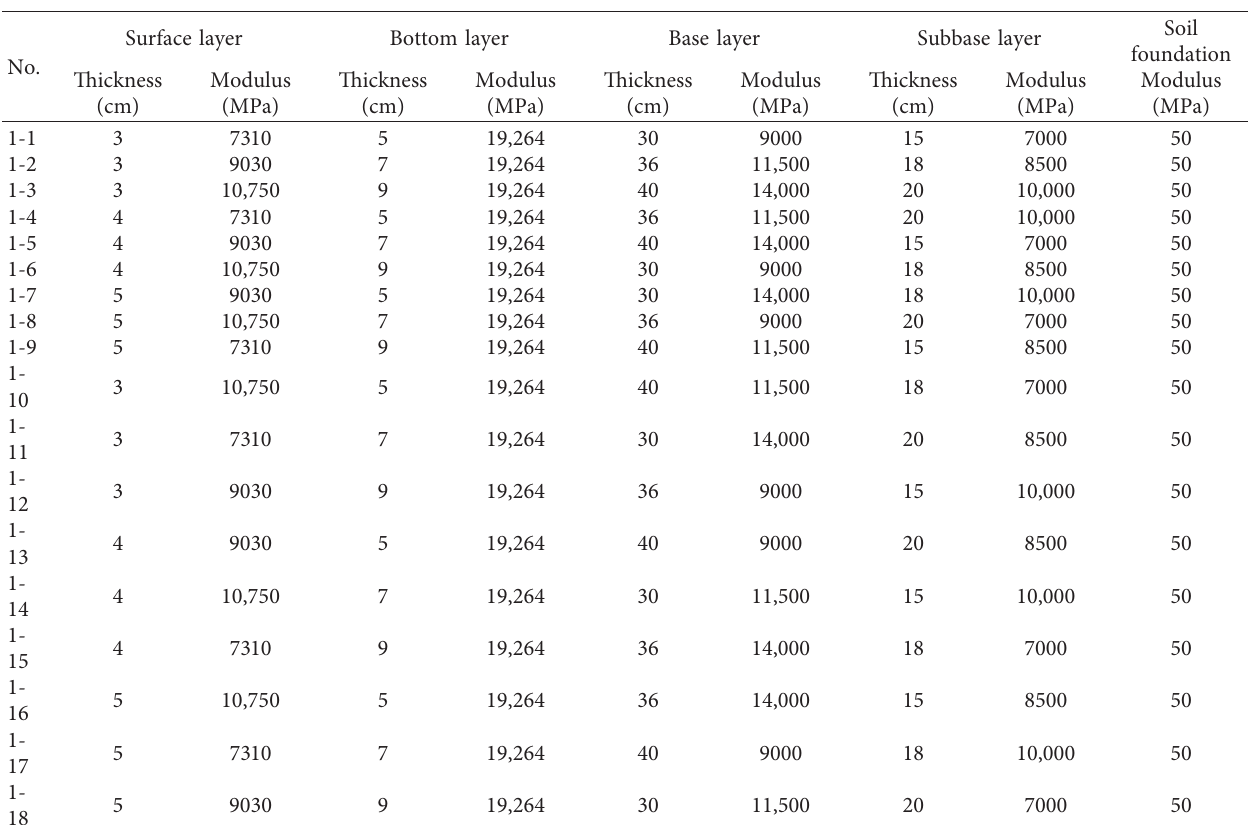
Table 3: Working condition I the orthogonal test